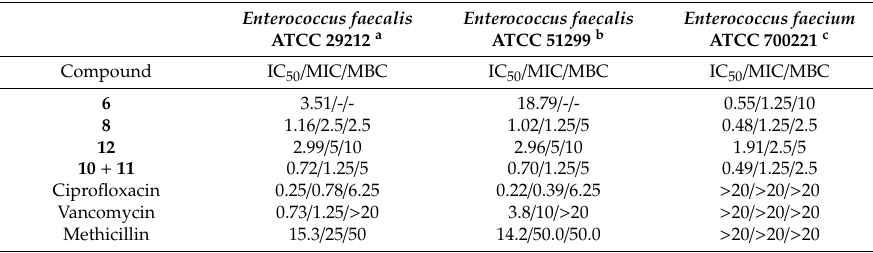
Table 4. Anti-VRE activities (in µ g / mL) of compounds 6 – 8 and 10 – 12 .